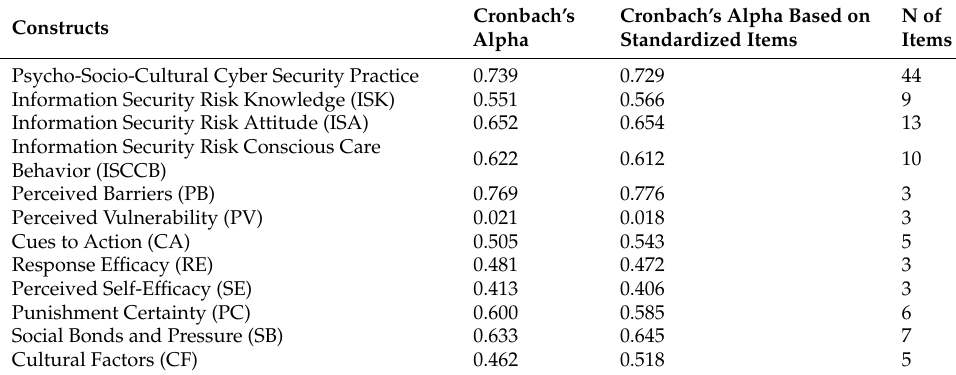
Table 4. Reliability